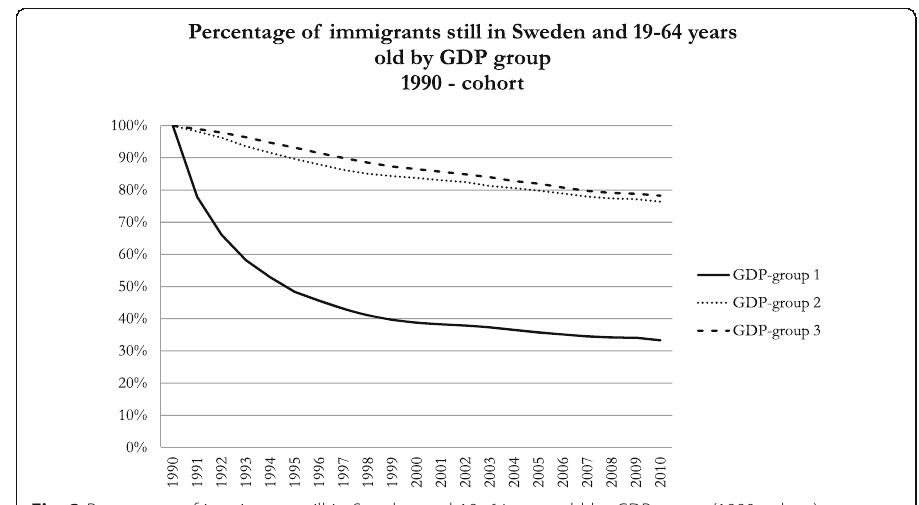
Fig. 3 Percentage of immigrants still in Sweden and 19 – 64 years old by GDP group (1990